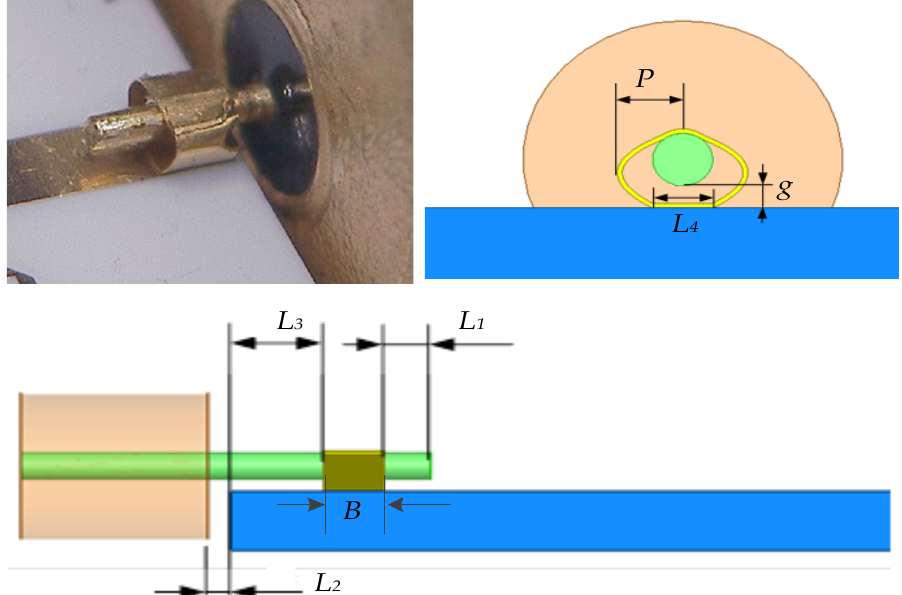
Figure 5. Gold-ribbon wrap bonding structure.